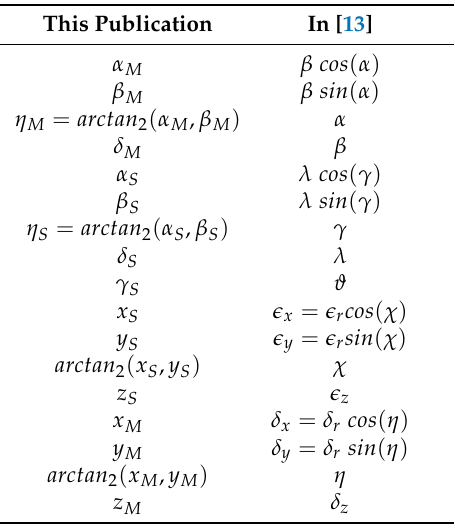
Table A2. Comparison of assembly parameters used in [13] with corresponding variables in this